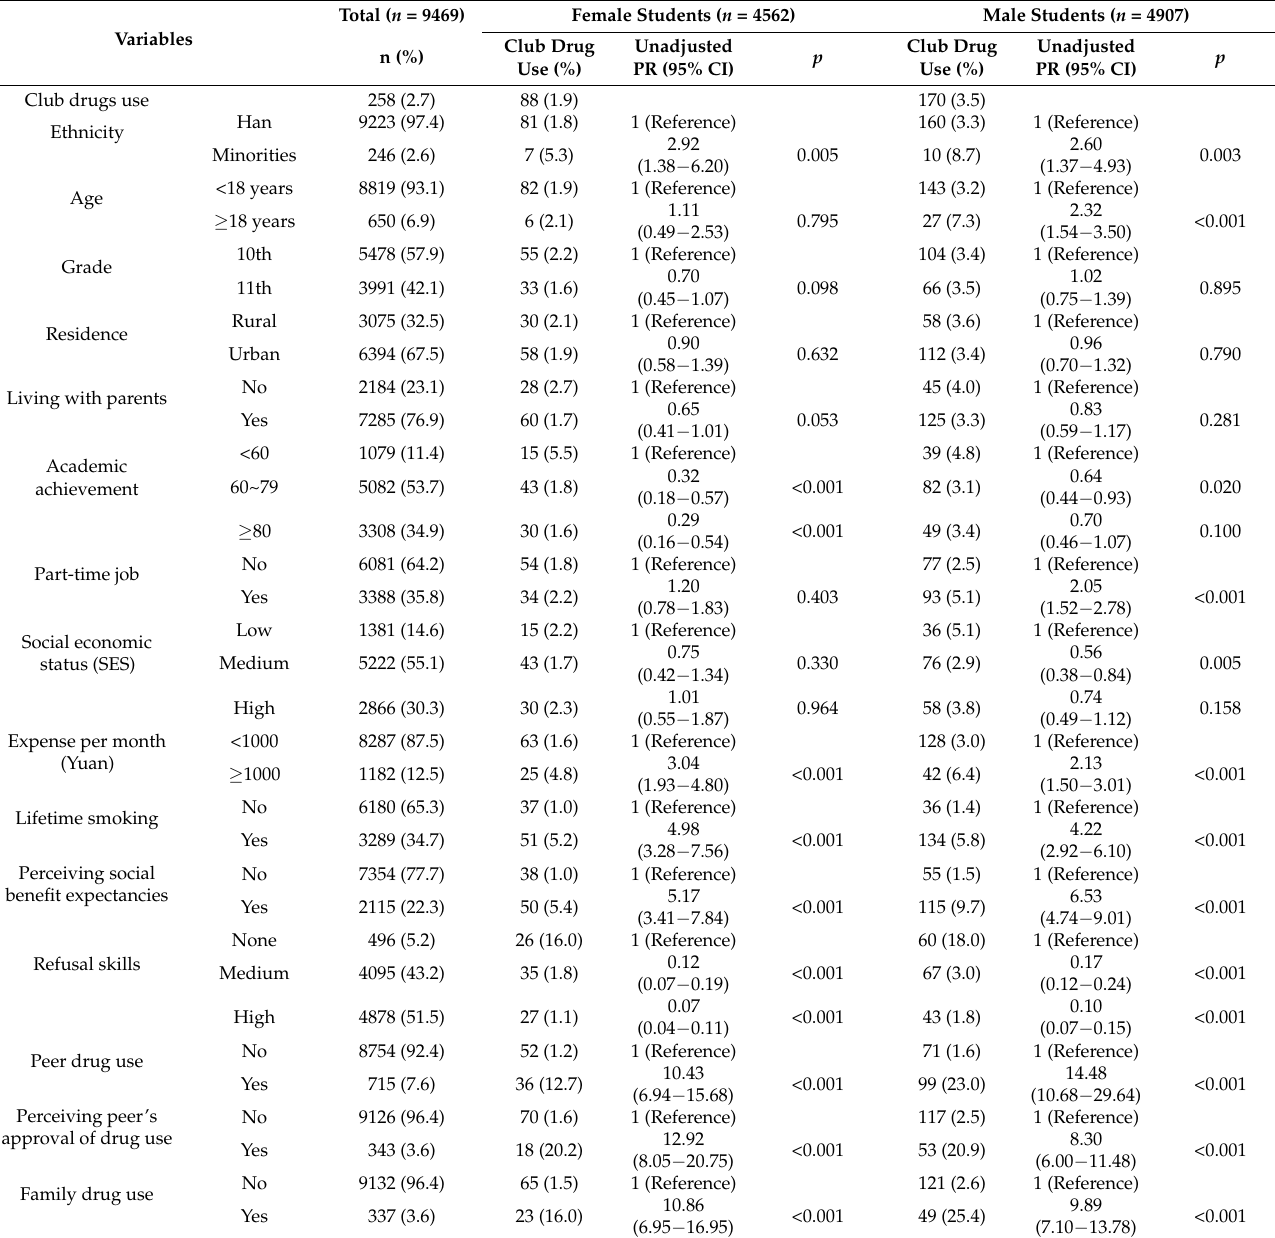
Table 1. Demographic characteristics of the total sample, unadjusted prevalence ratios (PR) and 95% confidence intervals (CIs) of lifetime club drug use among female and male